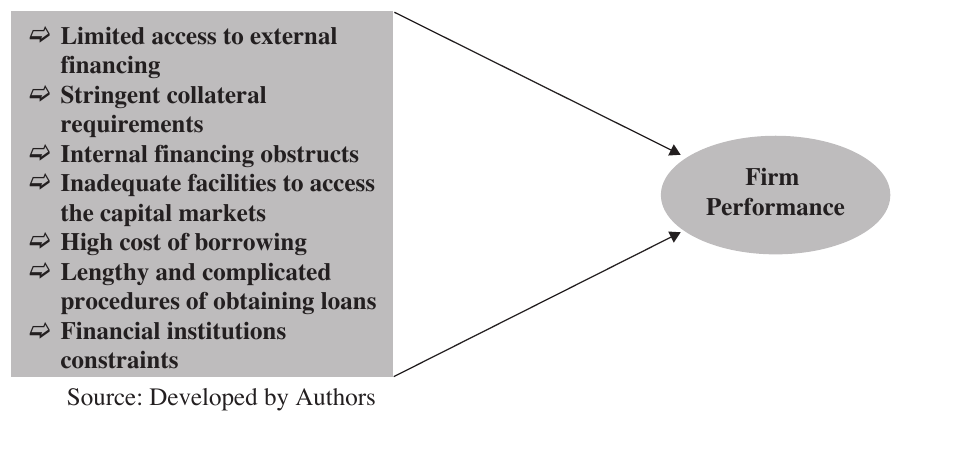
Figure 1: Conceptual Framework: Components of Financial Constraint